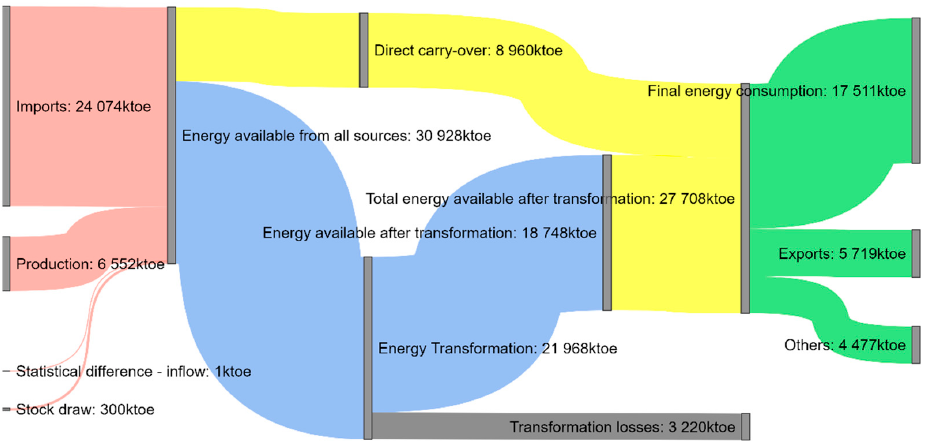
Figure 9. Portuguese energy balance flow according to the four phases of the analysis–2019 data (adopted from Eurostat data).